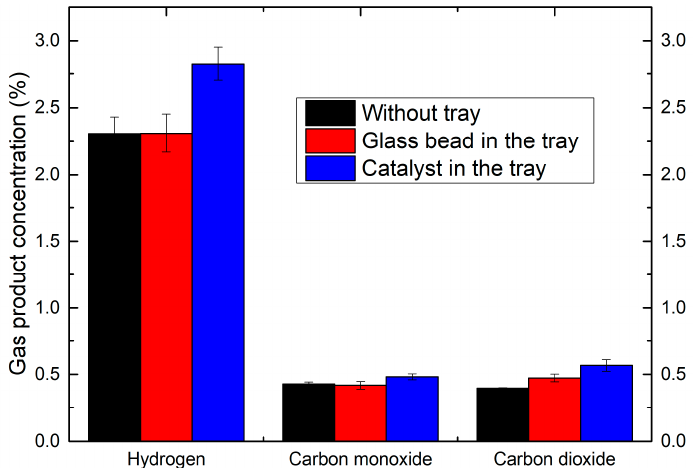
Figure 20. Effect of catalyst on the composition of the off-gas at a flow rate of 12 NL/min.